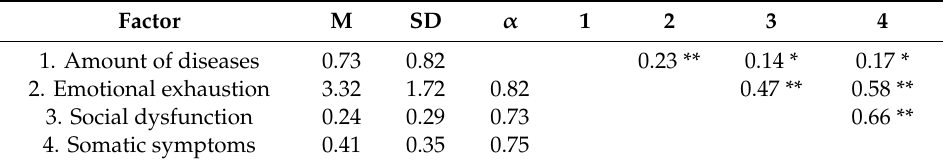
Table 1. Descriptive statistic and bivariate